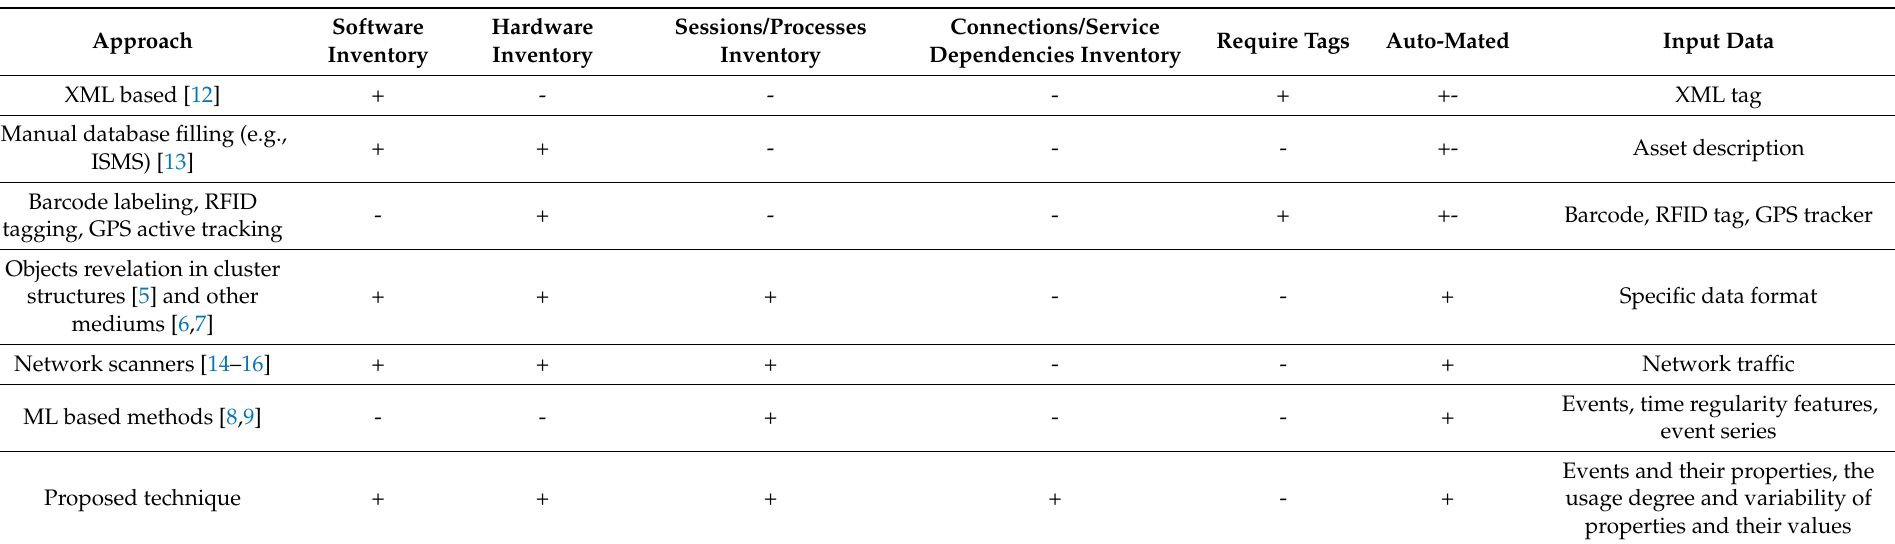
Table 1. Comparison of approaches to the asset